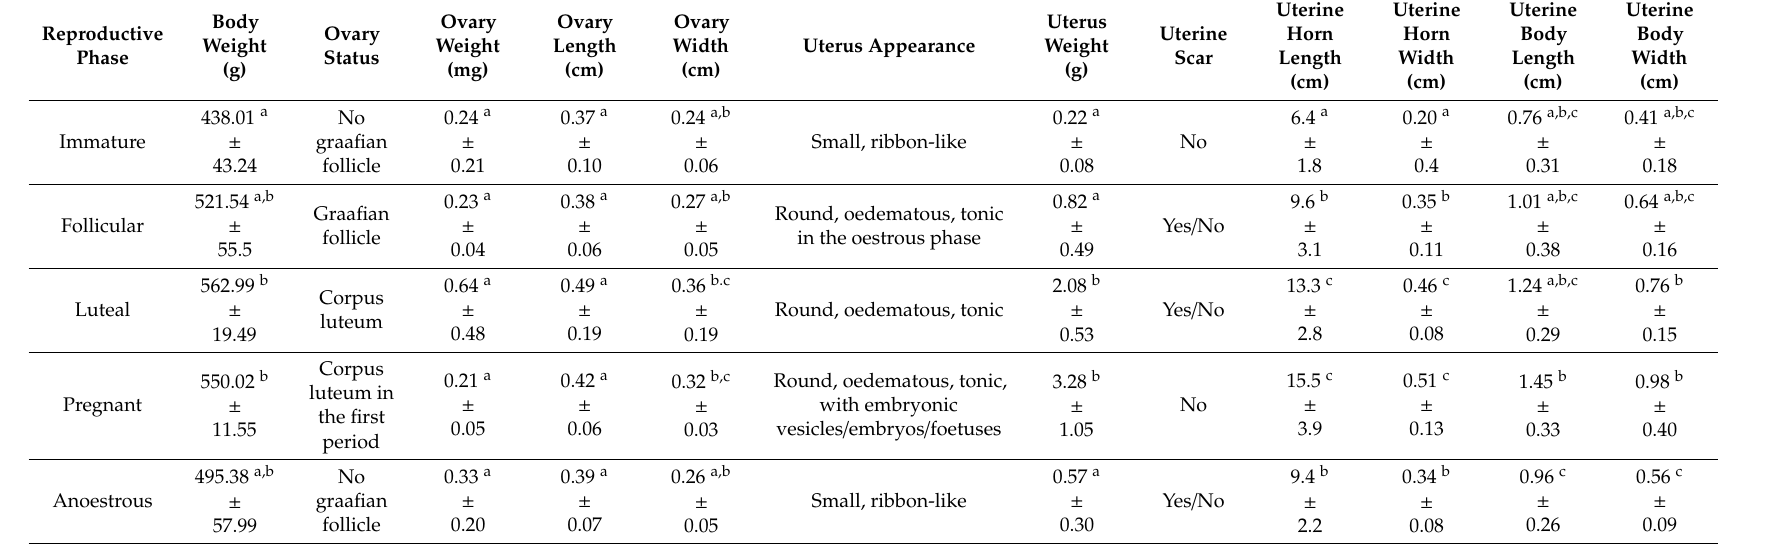
Table 1. Female breeding status according to body weight and the morphometric characteristics of the genital